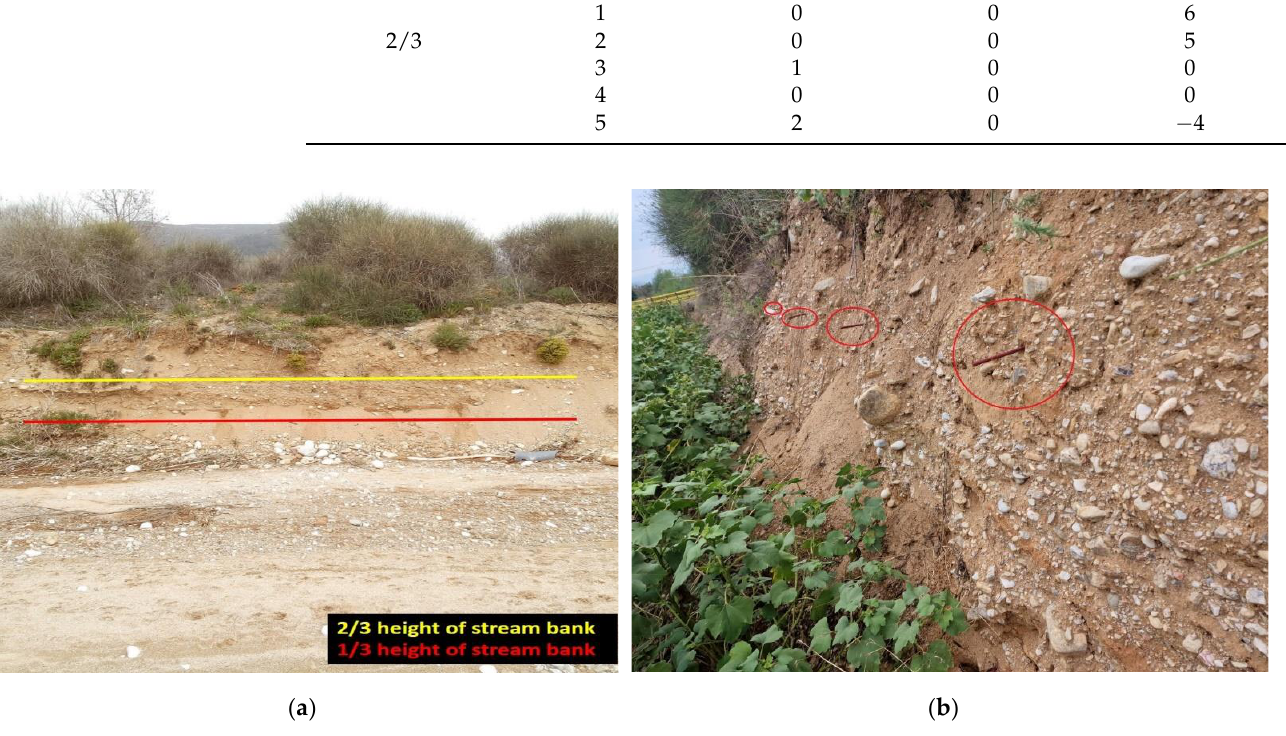
Figure 3. Erosion pins installed and measurements after erosion ( left ) and deposition ( right ) events.